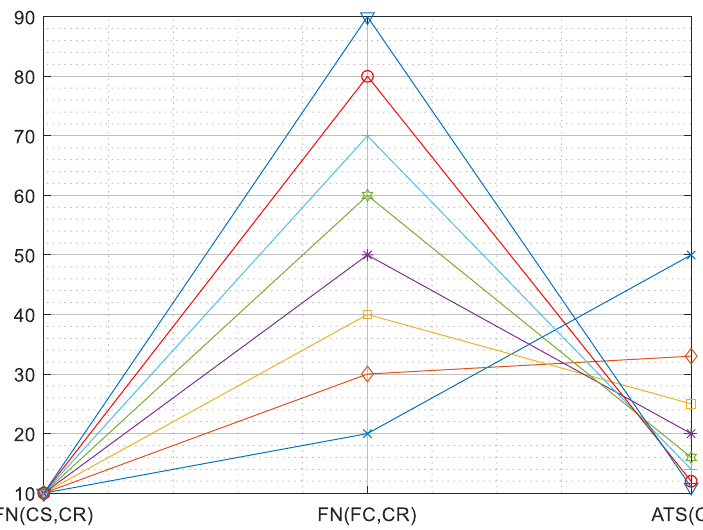
Figure 7. Attack target scale (ATS) .